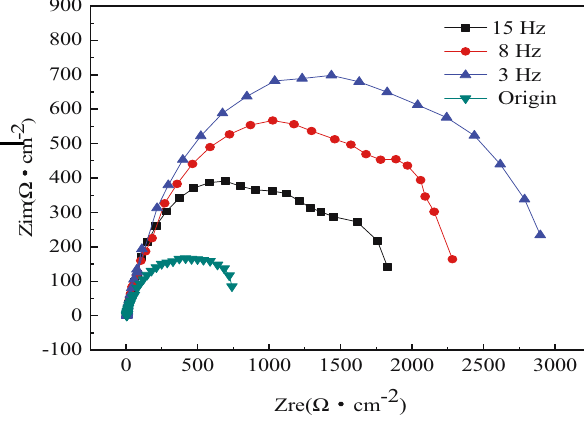
Figure 3: Impedance spectroscopy of brass alloy with and